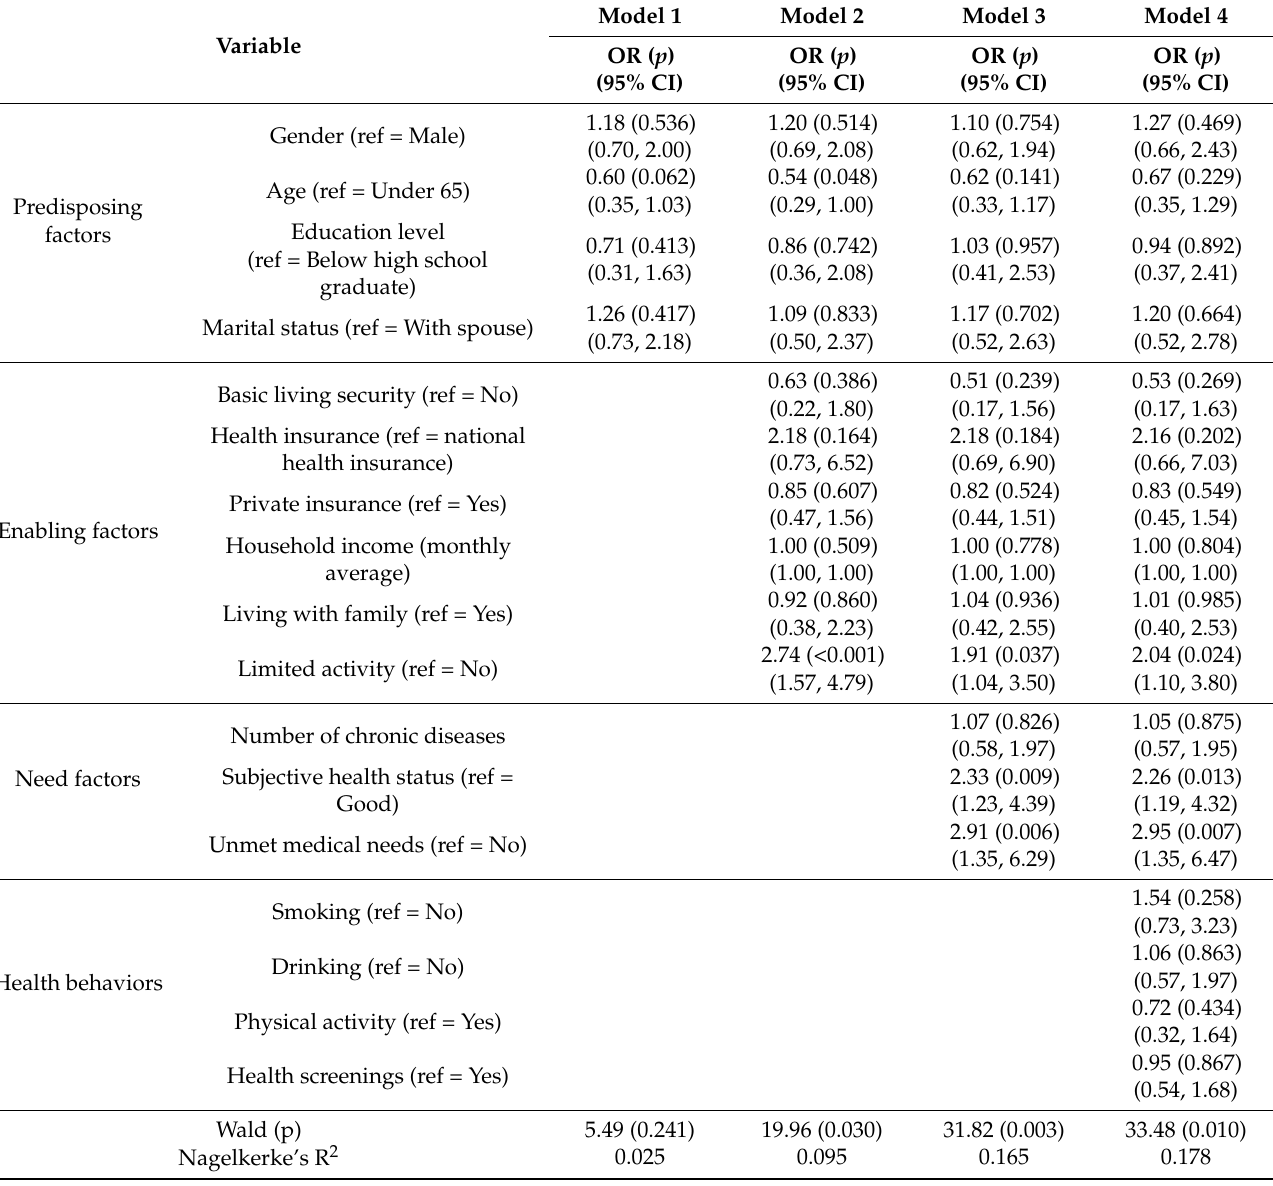
Table 6. Factors affecting anxiety/depression dimension of health-related quality of life in patients with multimorbidity according to Andersen’s model (South Korea,